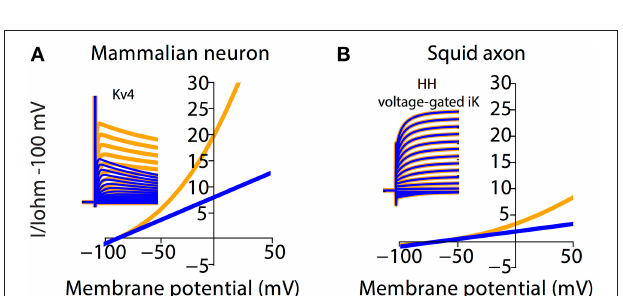
FIGURE 5 | Channel kinetic estimation using linear (Ohmic) passive membrane kinetics can cause substantial errors in cell types with large ionic concentration gradients. Effect of GHK leak currents on simulated voltage-clamp ofmammalian voltage-gated K + current, Kv4 (A) and K + current from the Hodgkin-Huxley model (B) The ionic concentration in (A) is the same as that in Figure 2 . The ionic concentration in (B) is adapted from Table 2 in Hodgkin (1951), which listed the approximate intra- and extracellular concentration of K + , Na + , and Cl − in Loligo axons (Hodgkin, 1951). Furthermore, E rest and membrane resistance values for the squid model were set to NEURON default values. Note that both the mammalian and squid axon K + currents were calculated by multiplying the gating variables with a GHK currentcomponent.SimulationsusingOhmicandGHKleakcurrentsarecolored blue and orange, respectively. The initial fast transient is the capacitive current.